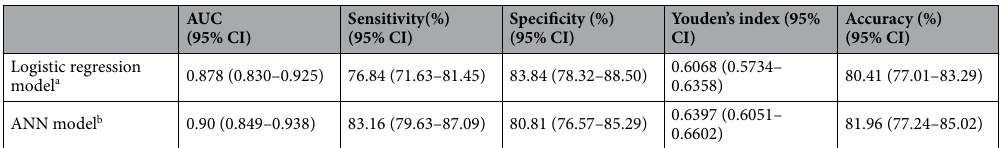
Table 6. The evaluation indicators of different predictive models in validation set. AUC area under the curve, ANN artificial neural network. a When compared with Logistic regression model, there was statistical difference in AUC ( P < 0.05). b When compared with ANN model, there was statistical difference in AUC ( P <